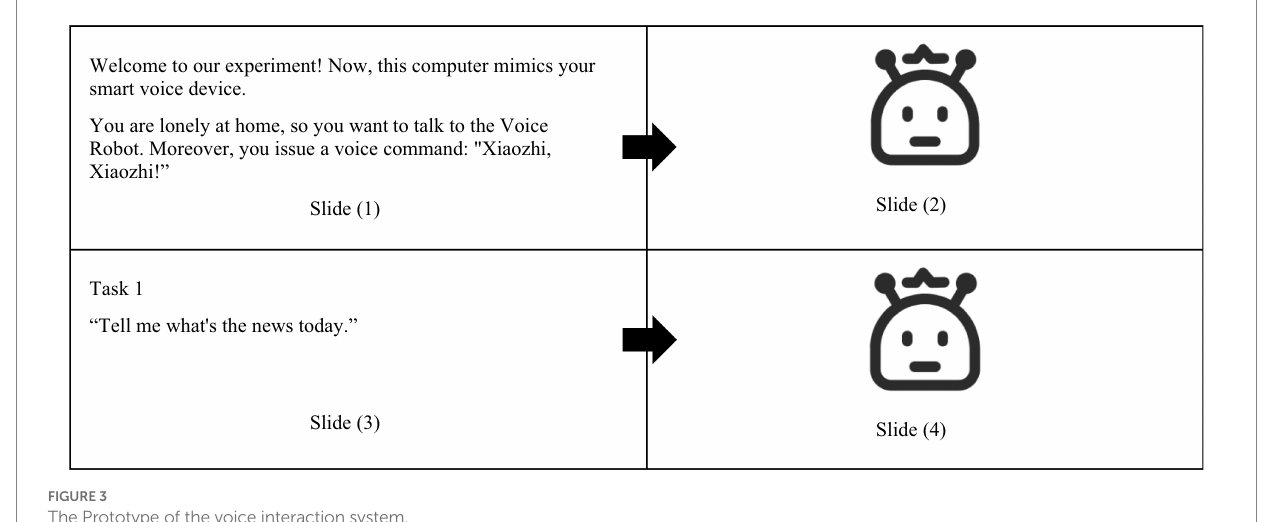
FIGURE 3 The Prototype of the voice interaction system.